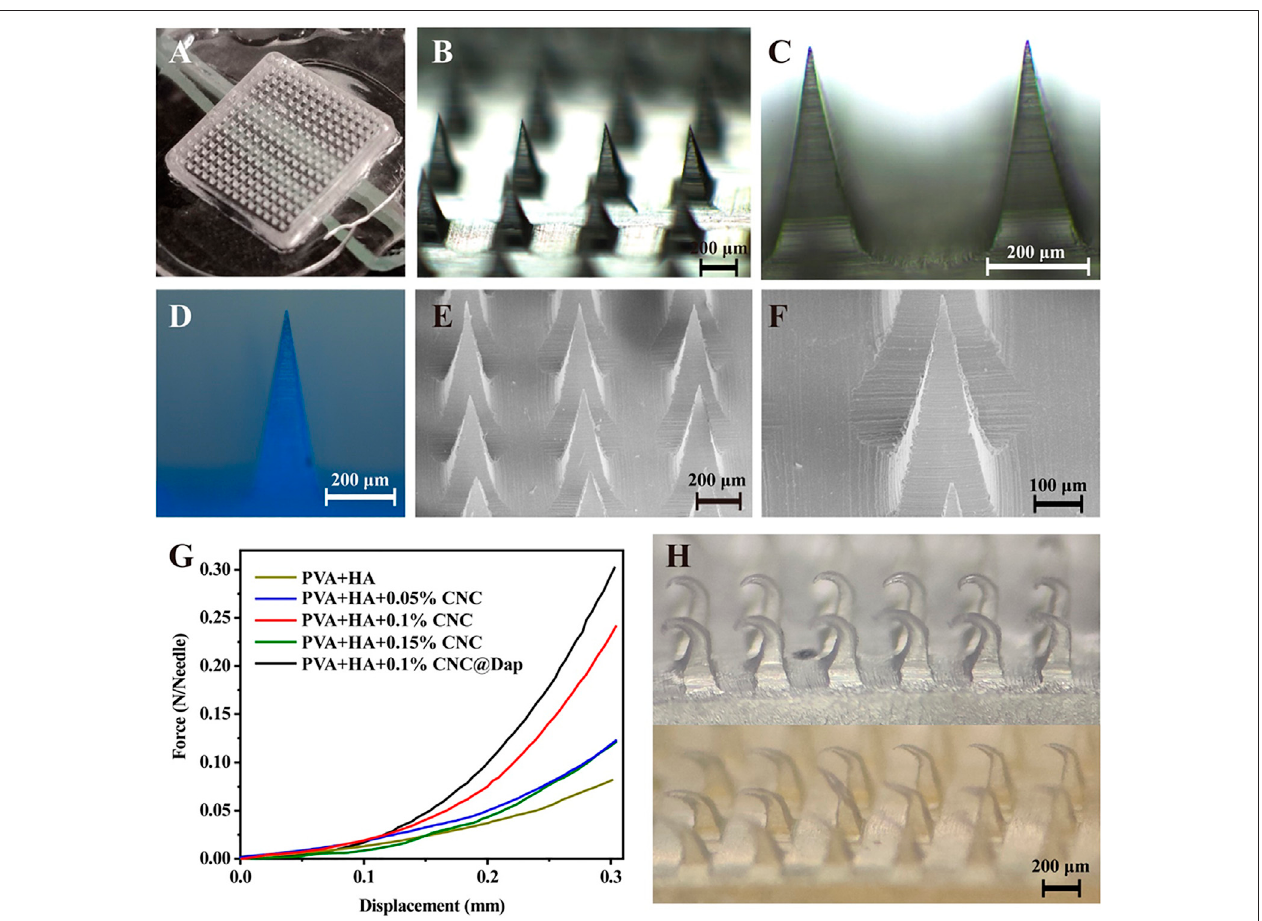
FIGURE 2 | Morphology and mechanical properties of the MN were determined. (A – C) Morphology of a blank MN under different magni fi cation of an optical microscope. (D) FluorescenceimageofaMNloadedwithDaphatascaleof200 μ m. (E,F) ImagesofanMNunderSEMatscalesof100and200 μ m. (G,H) Testresults ofmechanicalproperties oftheMNandopticalmicroscopeimagesofablankMN(above)anddrug-loadedMN(below)after compression, themicroneedlesintheblank and drug loading groups had corresponding morphological changes (H) .